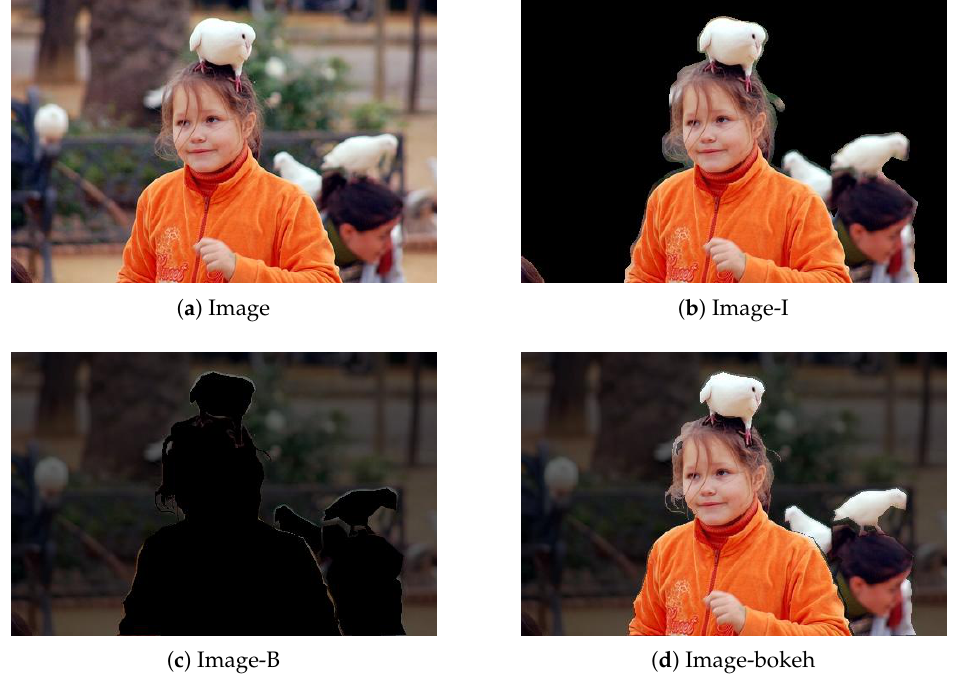
Figure 3. Image visualization after adding the bokeh module: ( a ) original image, ( b ) the domain of interest ϕ I , ( c ) the background blurred domain ϕ B , and ( d ) Image-bokeh, namely a combination of the latter